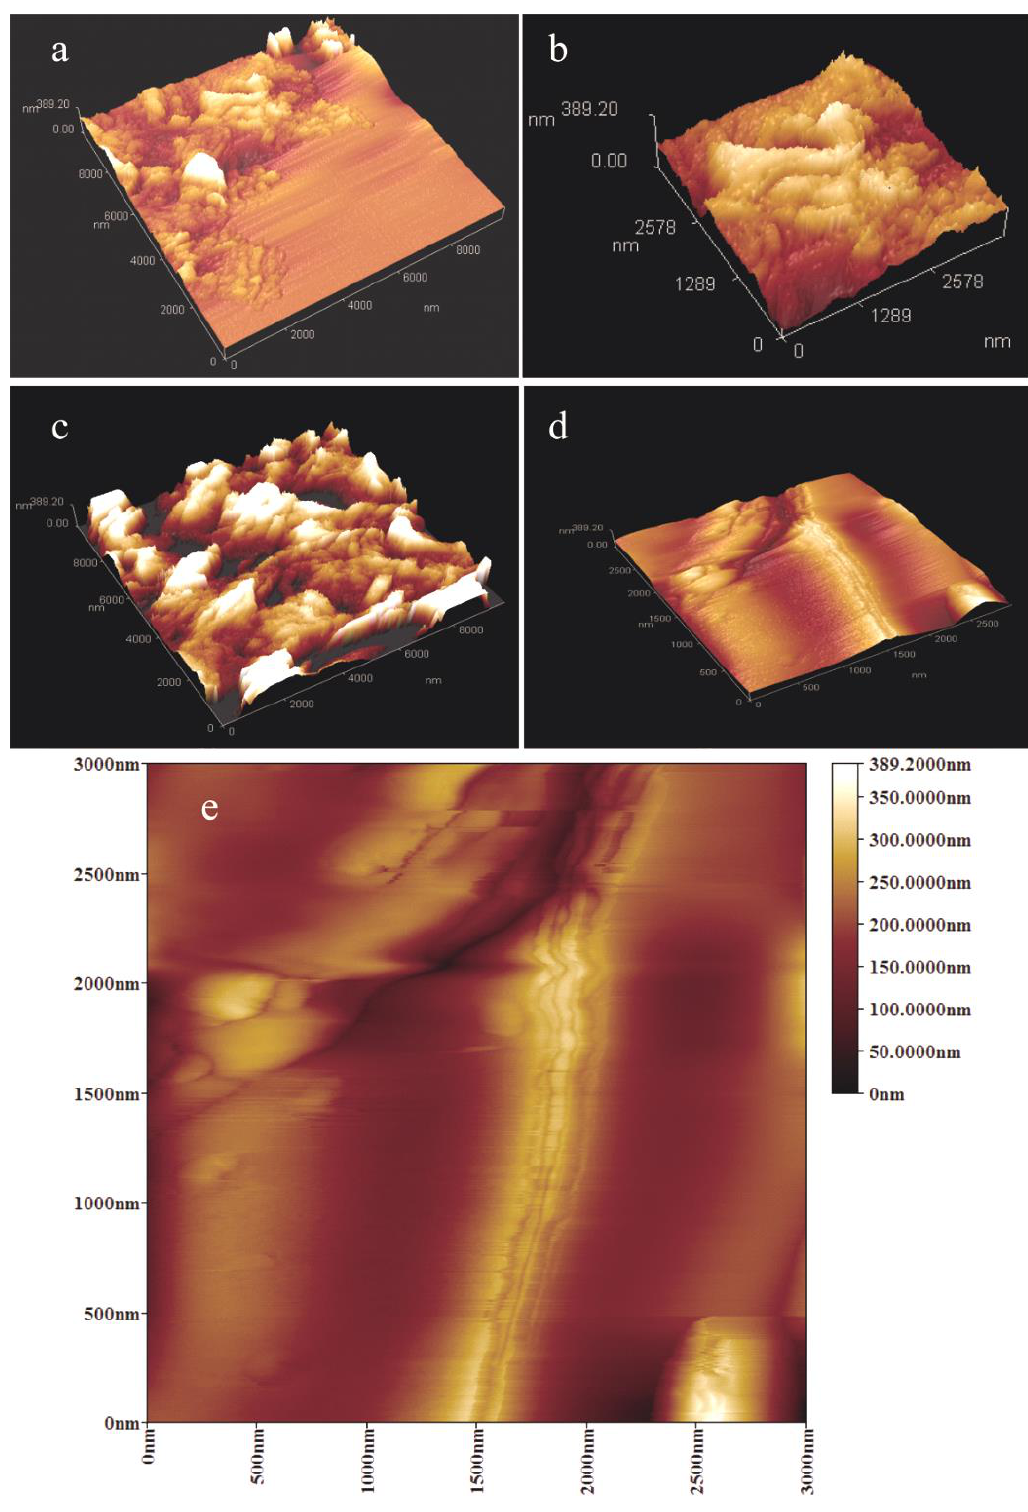
Figure 9. AFM morphologies of single microcapsule surface with/without graphene/organic hybrid structure shells, ( a ) a microcapsule (MG-0) surface without graphene; ( b – d ) microcapsule samples of MG-2, MG-4 and MG-6, and ( e ) an enlarged AFM morphology of MG-6.